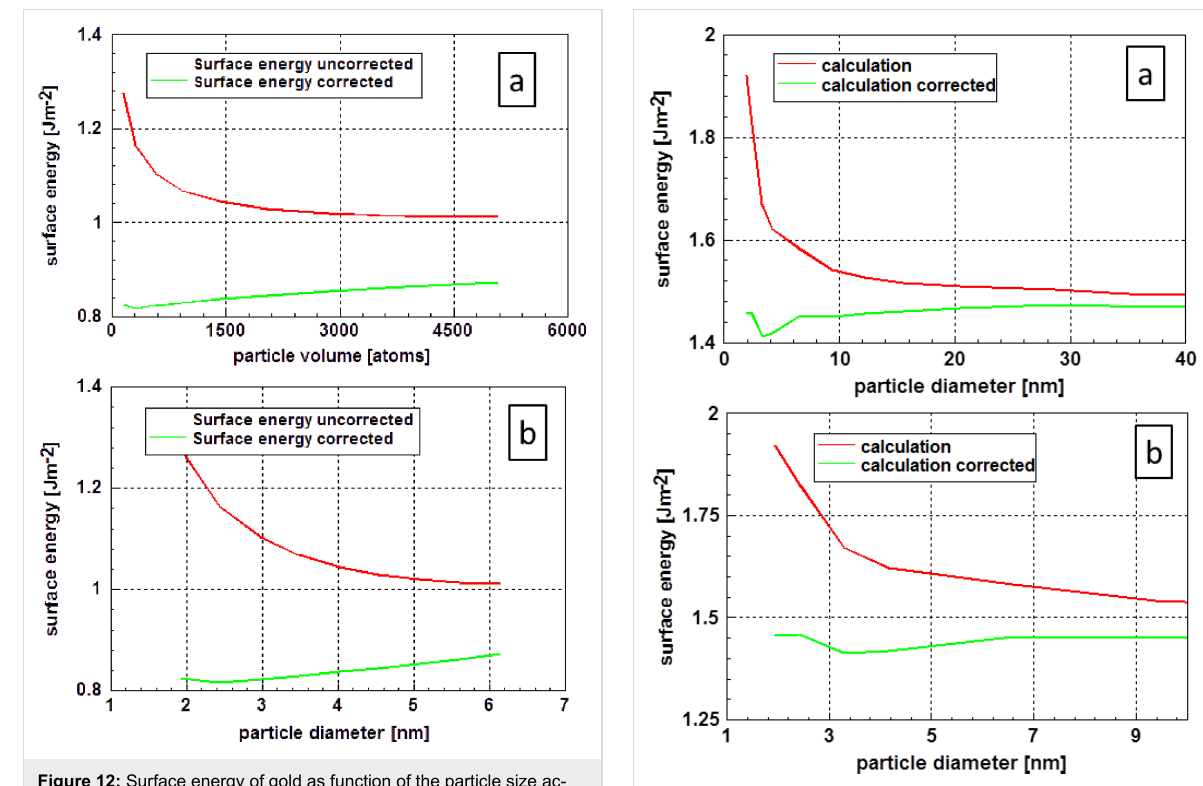
Figure 12: Surface energy of gold as function of the particle size ac- cording to Ali et al. [51]. The graphs show the original data of Ali et al. [51] and that corrected according to Holec et al. [53]. In the original paper, the size of the icosahedron-shaped particle is defined by the number of atoms in the particle (a). The size dependence of the sur- face energy, obtained by both assumptions, is plotted versus the parti- cle diameter assuming a spherical particle of equal volume (b).